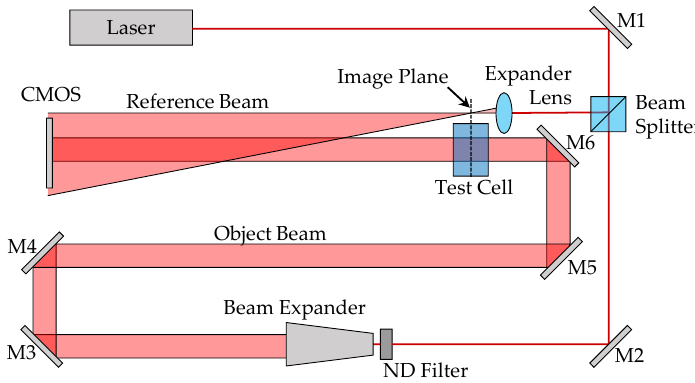
Figure 1. Schematic of the Cavan–Meyer Lensless Fourier Transform Digital Holographic (LFTDH) interferometer. M1–6 are turning mirrors, and the ND filters were a neutral density filter, added to equalise the intensity of the reference and object beams at the CMOS